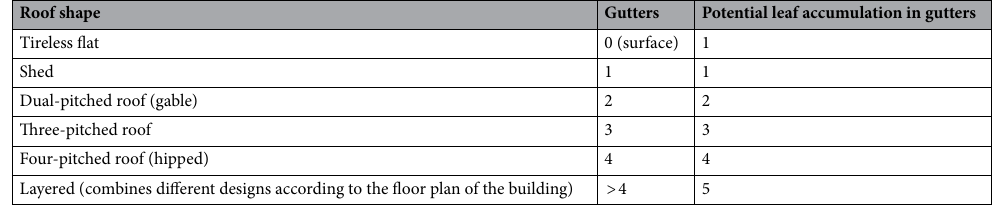
Table 4. Potential leaf accumulation in